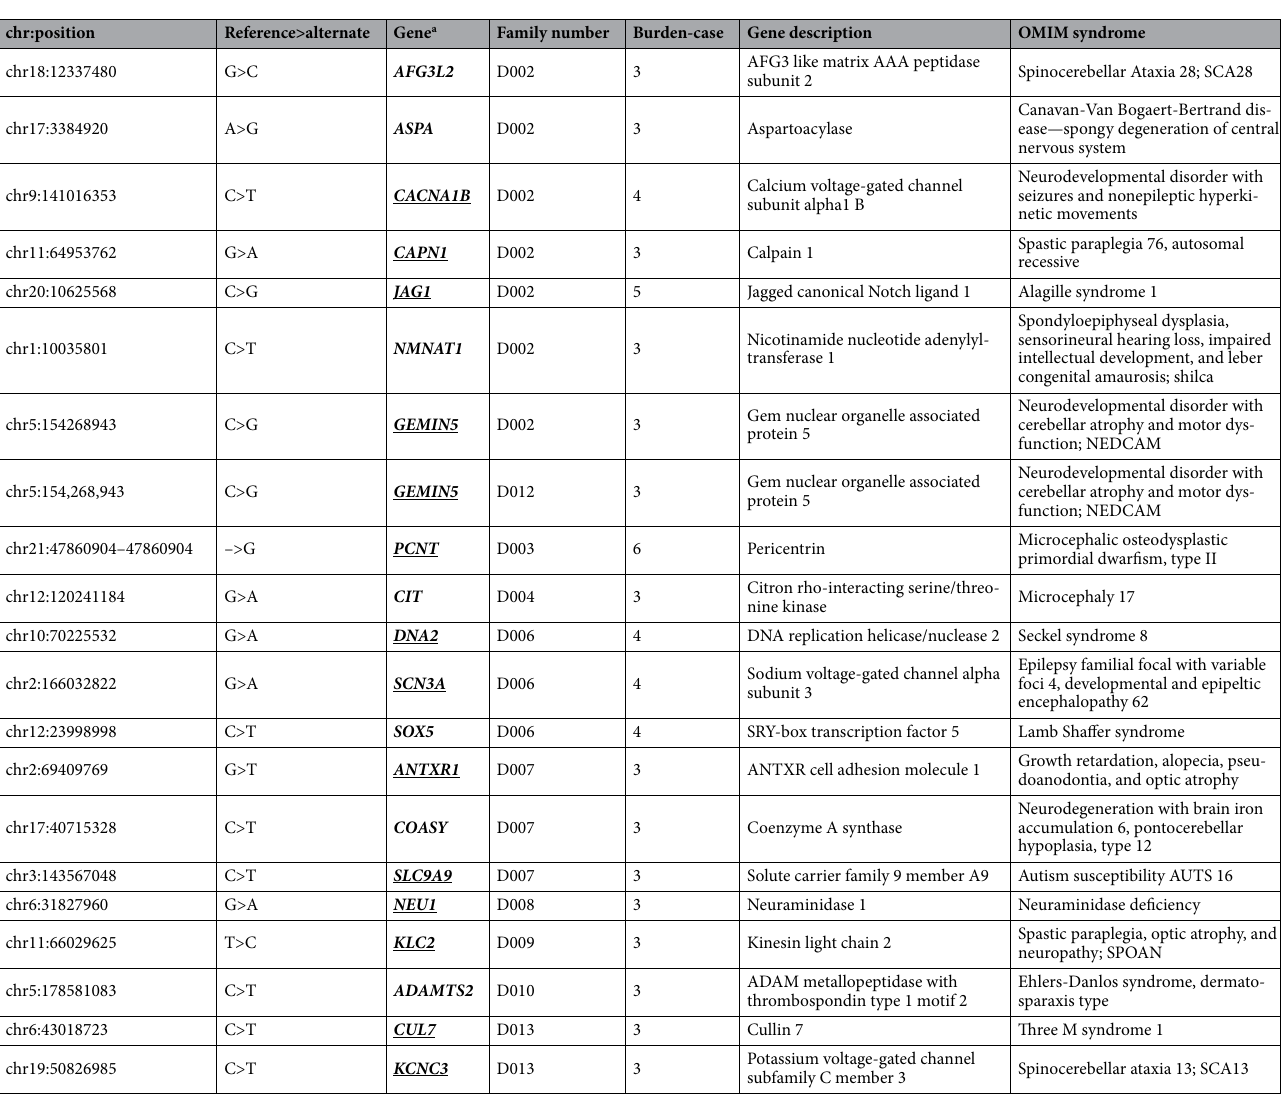
Table 2. Variants segregating within families with SMI in genes implicated in Mendelian syndromes. a The underlined genes are those that harbored shared-stringent variants defined by stringent prioritization